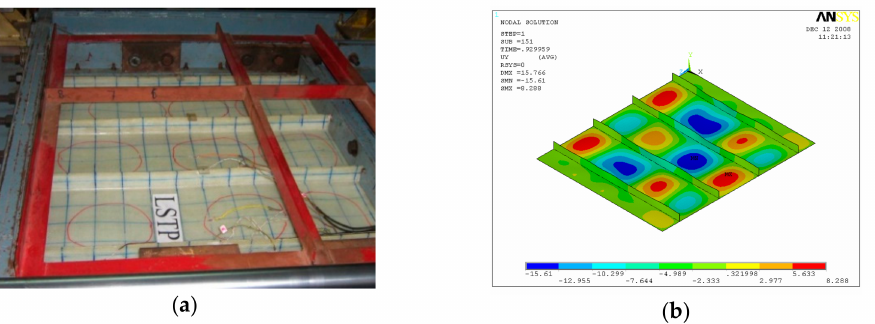
Figure 11. Buckling of LSTP1 ( a ) experiment ( b ) finite element analysis (FEA).